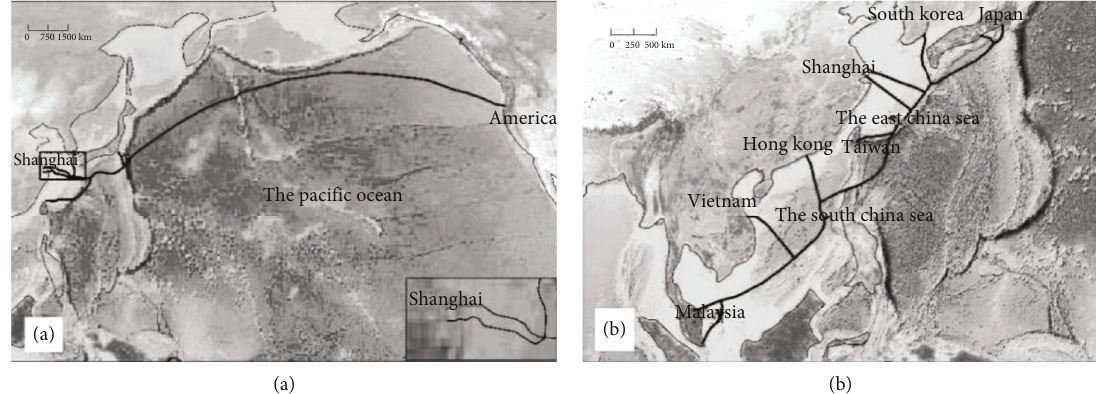
Figure 1: Schematic diagram of the completed international submarine optical fi ber cable in the East China Sea. (a) New Cross Paci fi c Cable Network (NCP) and (b) Asia Paci fi c Gateway